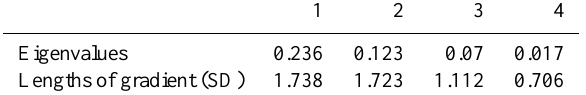
Table 4. Results of the detrended canonical correspondence analy- sis (DCCA). The short length of gradient for the first axis indicates a linear species–water-depth relationship in the surface samples. 1 2 3 4 Eigenvalues 0.236 0.123 0.07 0.017 Lengths of gradient (SD) 1.738 1.723 1.112